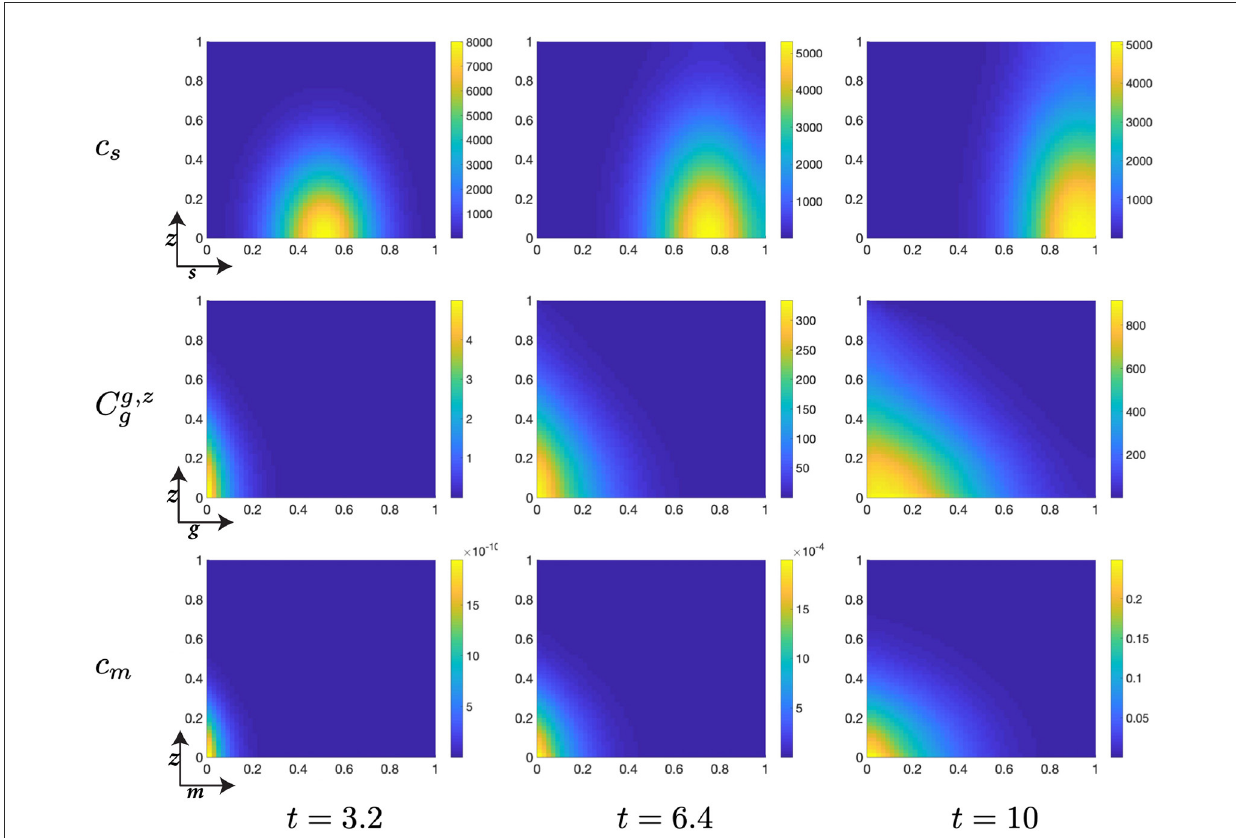
FIGURE6 Structured cell populations with S-cyclins ( s ) and DNA-damage ( z ), given in the S-phase ( c s ); G-cyclins ( g ) and DNA-damage ( z ), given in the G-phase ( C g , z g ); and M-cyclins ( m ) and DNA-damage ( z ), given in the M-phase ( c m ), solved for t